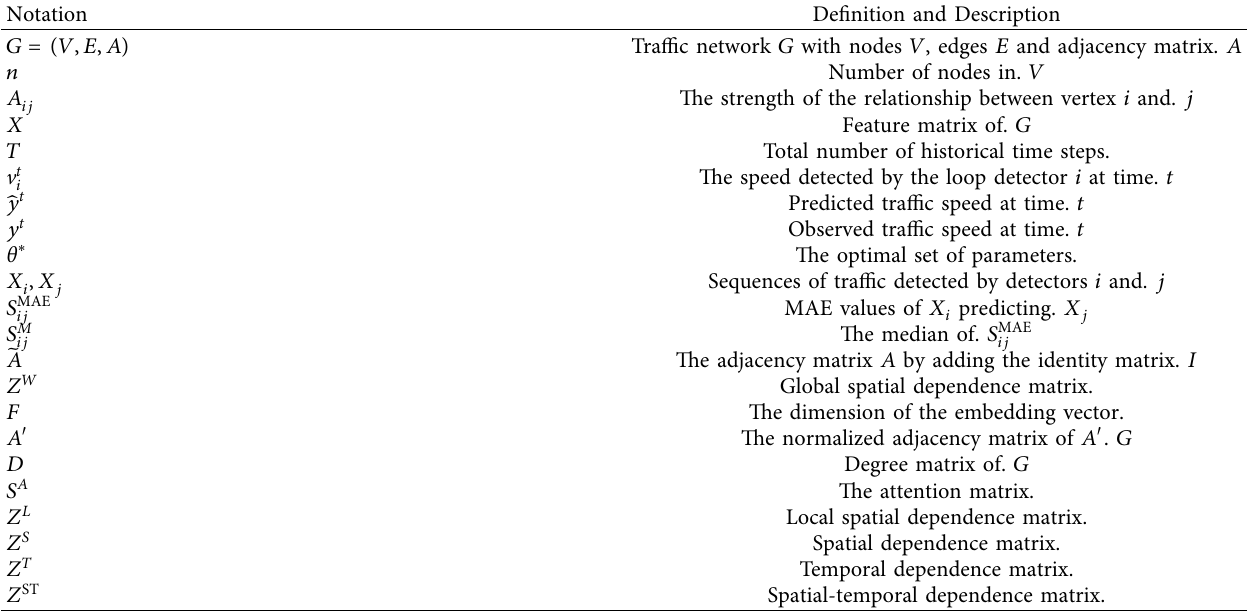
Table 1: Notations in